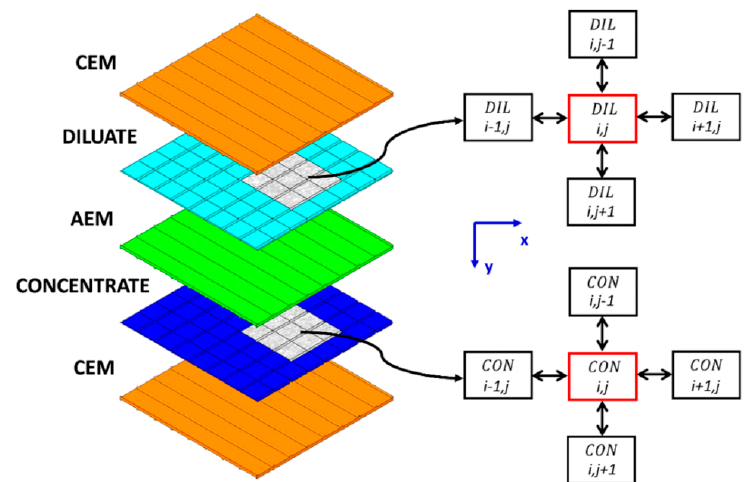
Figure 2. Sketch of a cell pair with diluate (DIL) and concentrate (CON) channels. Membranes are shown only for the sake of clarity but are not part of the computational domain. The bottom row reports a representation of the computational “molecules” adopted for the formulation of discrete balance equations in both channels. Membranes are not actually included in the computational domain. The hydrodynamic effects of the profiled membranes and their deformation are taken into account by using constitutive